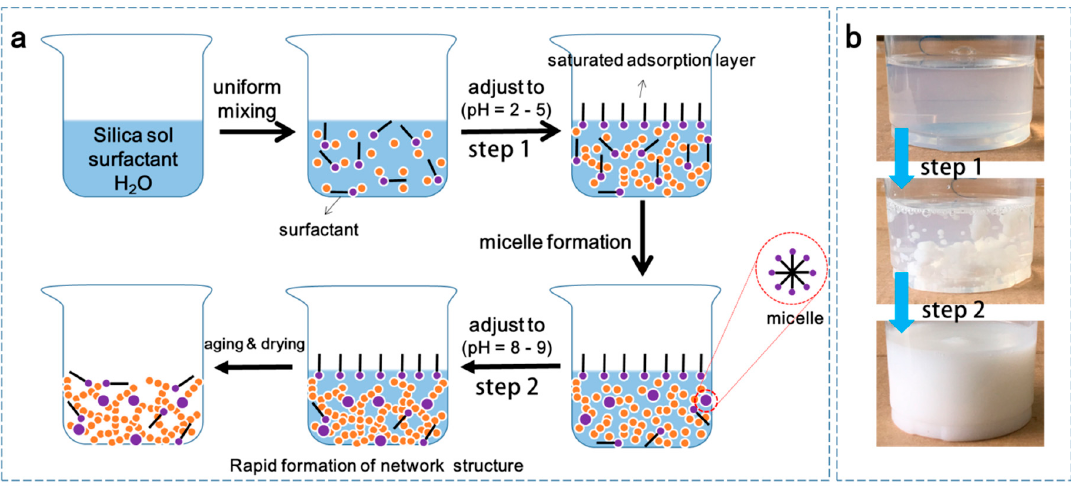
Figure 1. ( a ) Synthesis flowchart of silica aerogels prepared with surfactant. ( b ) Photographs of the gel evolution during the preparation of silica aerogels with surfactant.